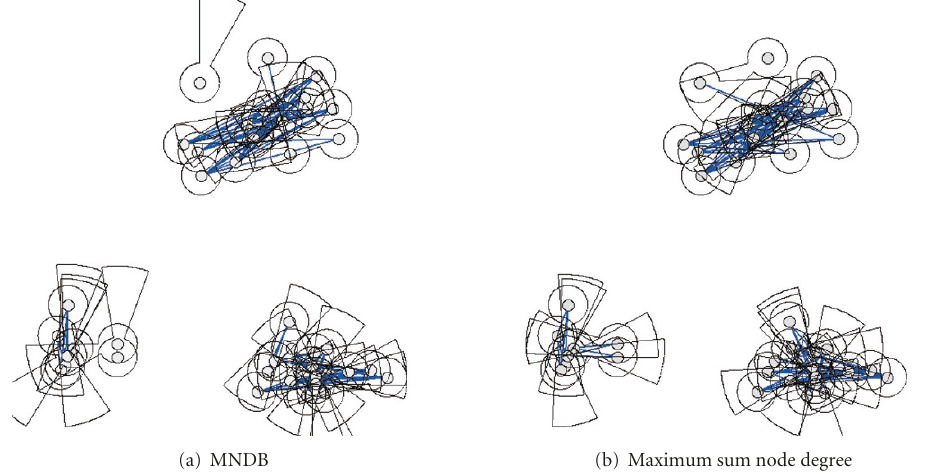
Figure 3: 40-node example